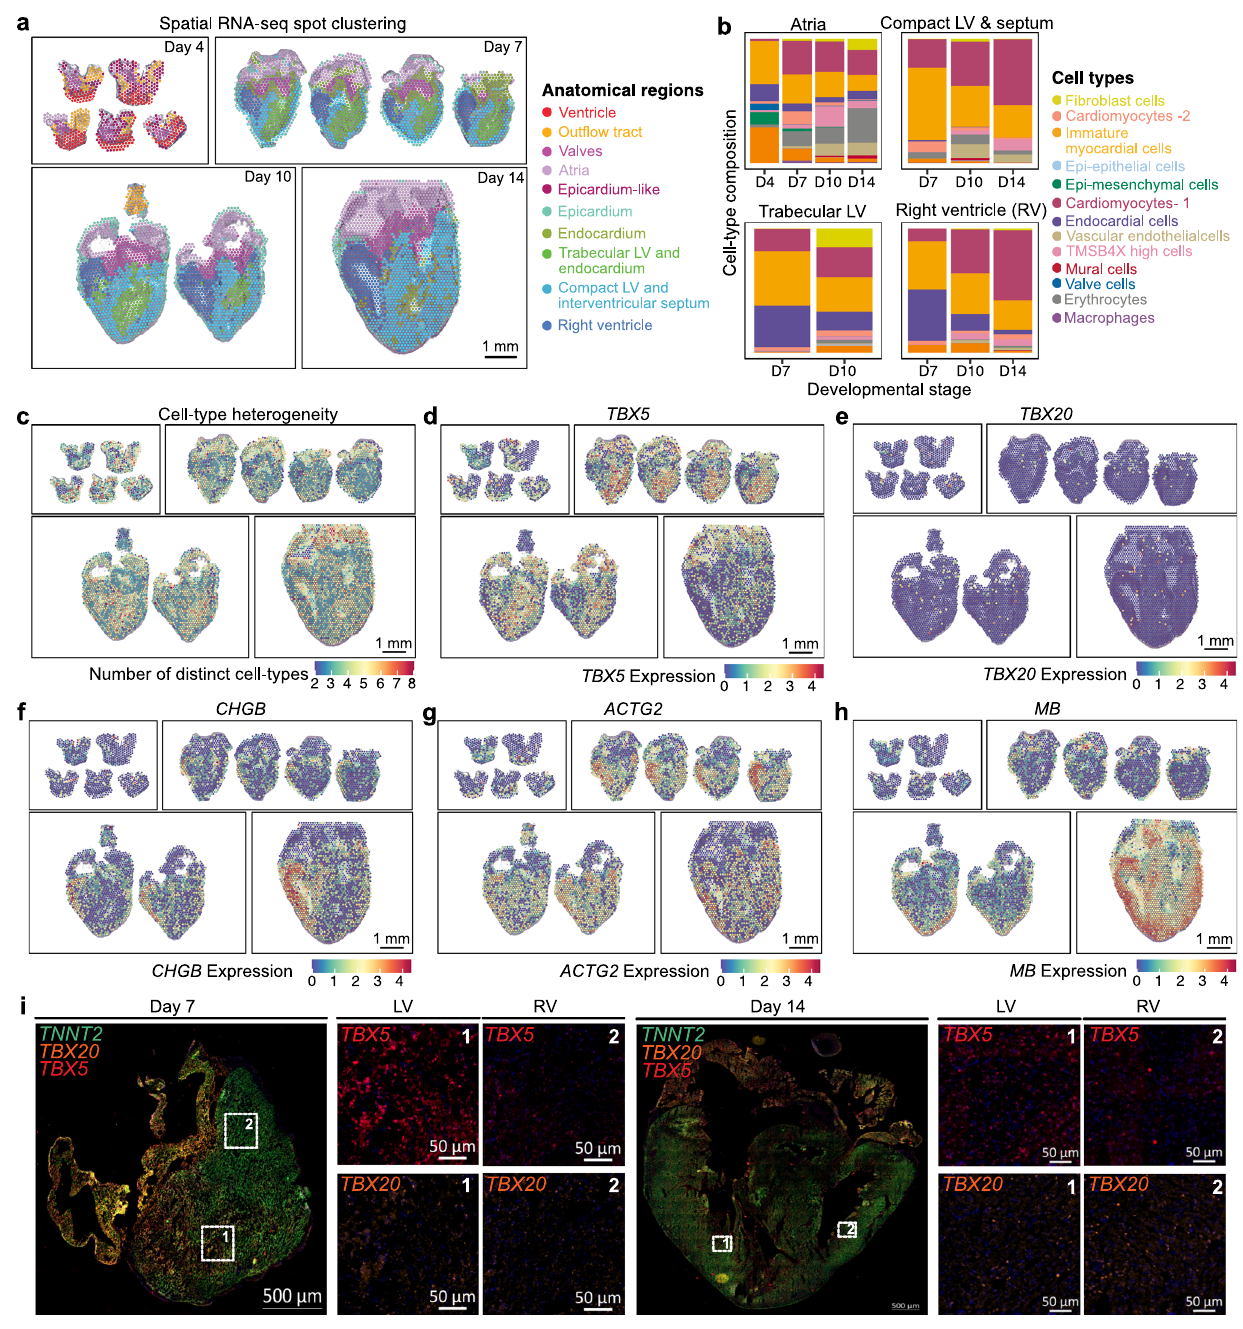
Fig. 3 Spatial RNA-seq identi fi es spatially restricted genes in cardiac tissue during development. a Spatial RNA-seq barcoded spots clustered by gene expression and labeled by tissue anatomical compartment for four developmental stages. b Average cell type composition across various tissue anatomical compartments. c Spatial map showing the cell type heterogeneity for every spot in cardiac tissue across stages. Cell type was estimated by enumerating the number of distinct cell-types with prediction scores greater than 5%. d – h Spatially resolved gene expression for spatially restricted genes. d TBX5 overexpressed in left ventricles on day 7 and day 10. e TBX20 showing no spatial restriction. f CHGB overexpressed in right ventricles across stages. g ACTG2 overexpressed in right ventricles on day 7. h MB expressed in compact myocardium on day 10 and day 14. MB expression increases with the developmental stage. i smFISH stained day 7 and day 14 hearts for TBX5 (red), TBX20 (orange), TNNT2 (green), and DAPI (blue) con fi rming TBX5 overexpressed in left ventricles of day 7 hearts but not day 14 and TBX20 showing no left or right ventricle expression differences. Representative images of three to four biological